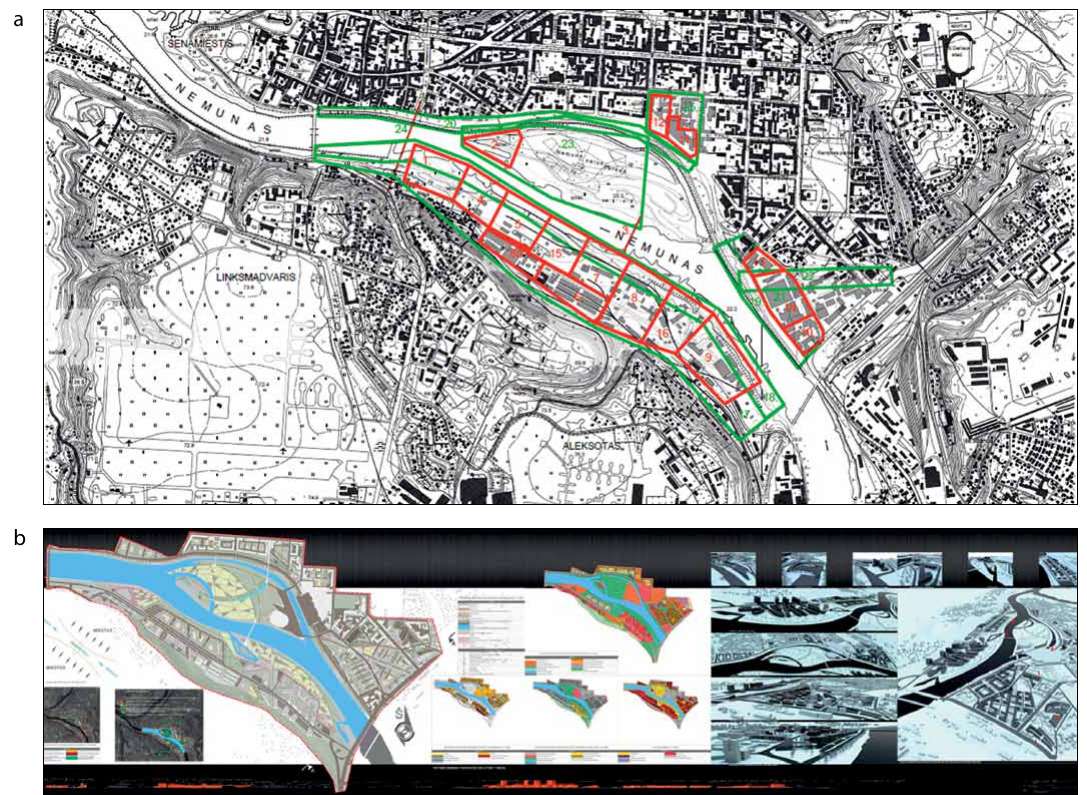
fig. 4. Topics of the final bachelor degree project (a) are formulated on the base of the urban project that